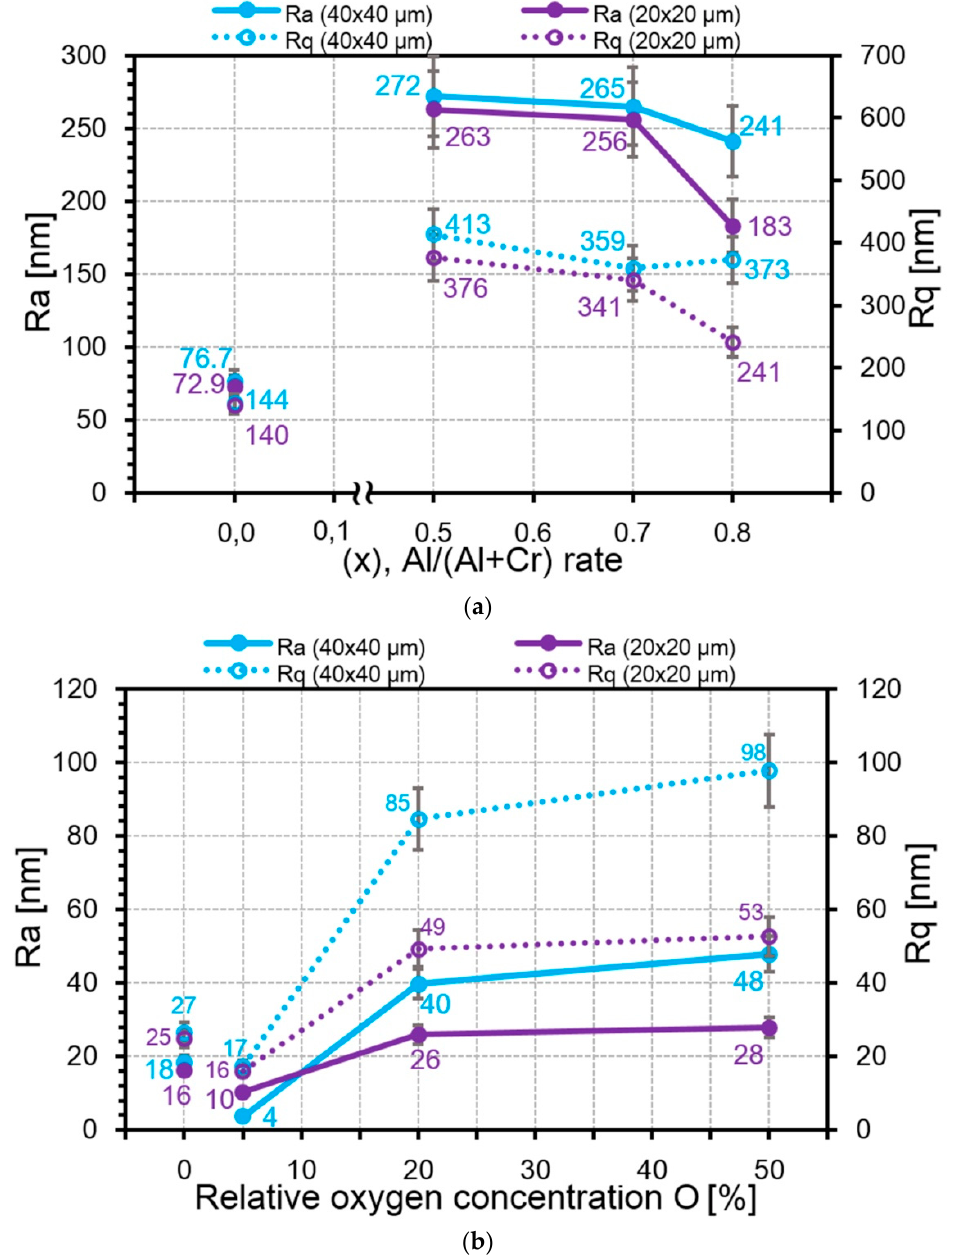
Figure 9. The dependences of Ra and Rq from the element concentration: ( a ) aluminum in the AlCrN coatings; ( b ) oxygen in the CrON coatings.